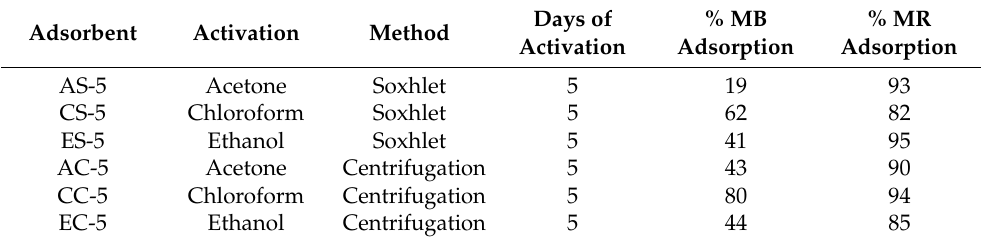
Table 5. Performance of the adsorbent at various activations and methods of